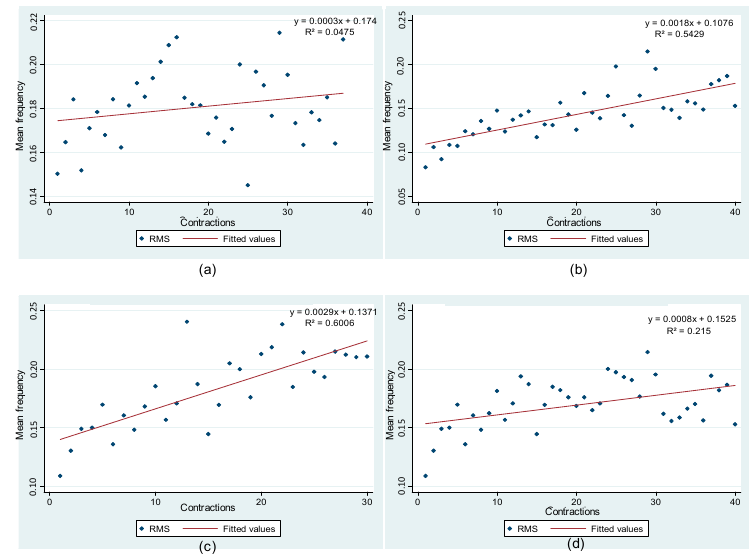
Figure 8. Results obtained with linear regression in the amplitude analysis for player 7: ( a ) Routine 1; ( b ) Routine 2; ( c ) Routine 3; ( d ) Total.